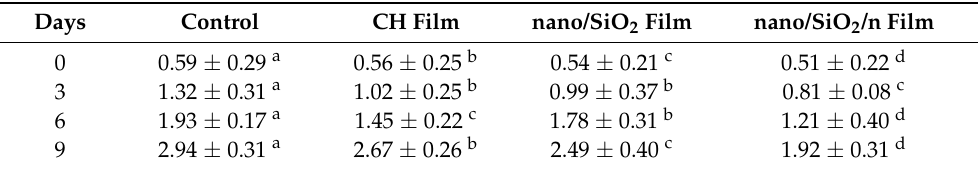
Table 2. Effects of novel coating on yeast and mold counts (log CFU/g) on cantaloupe fruits during the storage